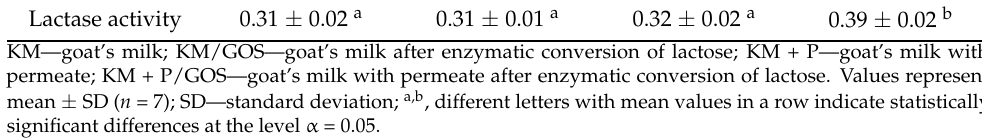
Table 6. Lactase activity ( µ kat/100 g) in kefir. KM KM/GOS KM + P KM + P/GOS Lactase activity 0.31 ± 0.02